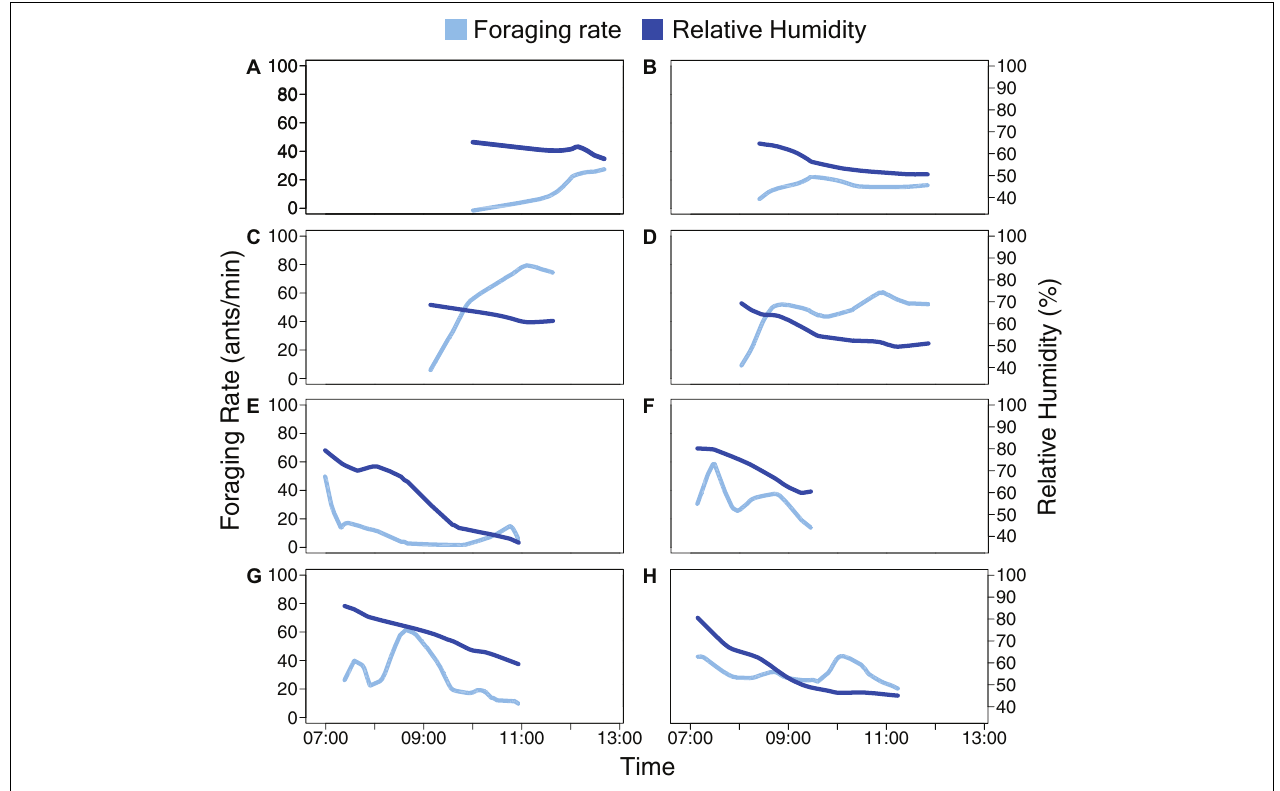
FIGURE 1 | Foraging rate and humidity. Smoothed outgoing foraging rates for all ants are shown in light blue. Relative humidity is shown in dark blue. Each row of two panels shows the data for Days 1 and 2 for one colony: (A) Colony 859, August 20, 2017; (B) Colony 859, August 21, 2017; (C) Colony 1107, August 20, 2017; (D) Colony 1107, August 21, 2017; (E) Colony 1242, August 22, 2018; (F) Colony 1242, August 23, 2018; (G) Colony 1368, August 24, 2018; (H) Colony 1368, August 25, 2018. TABLE 1 | The numbers of recorded forager trips for marked and unmarked ants.